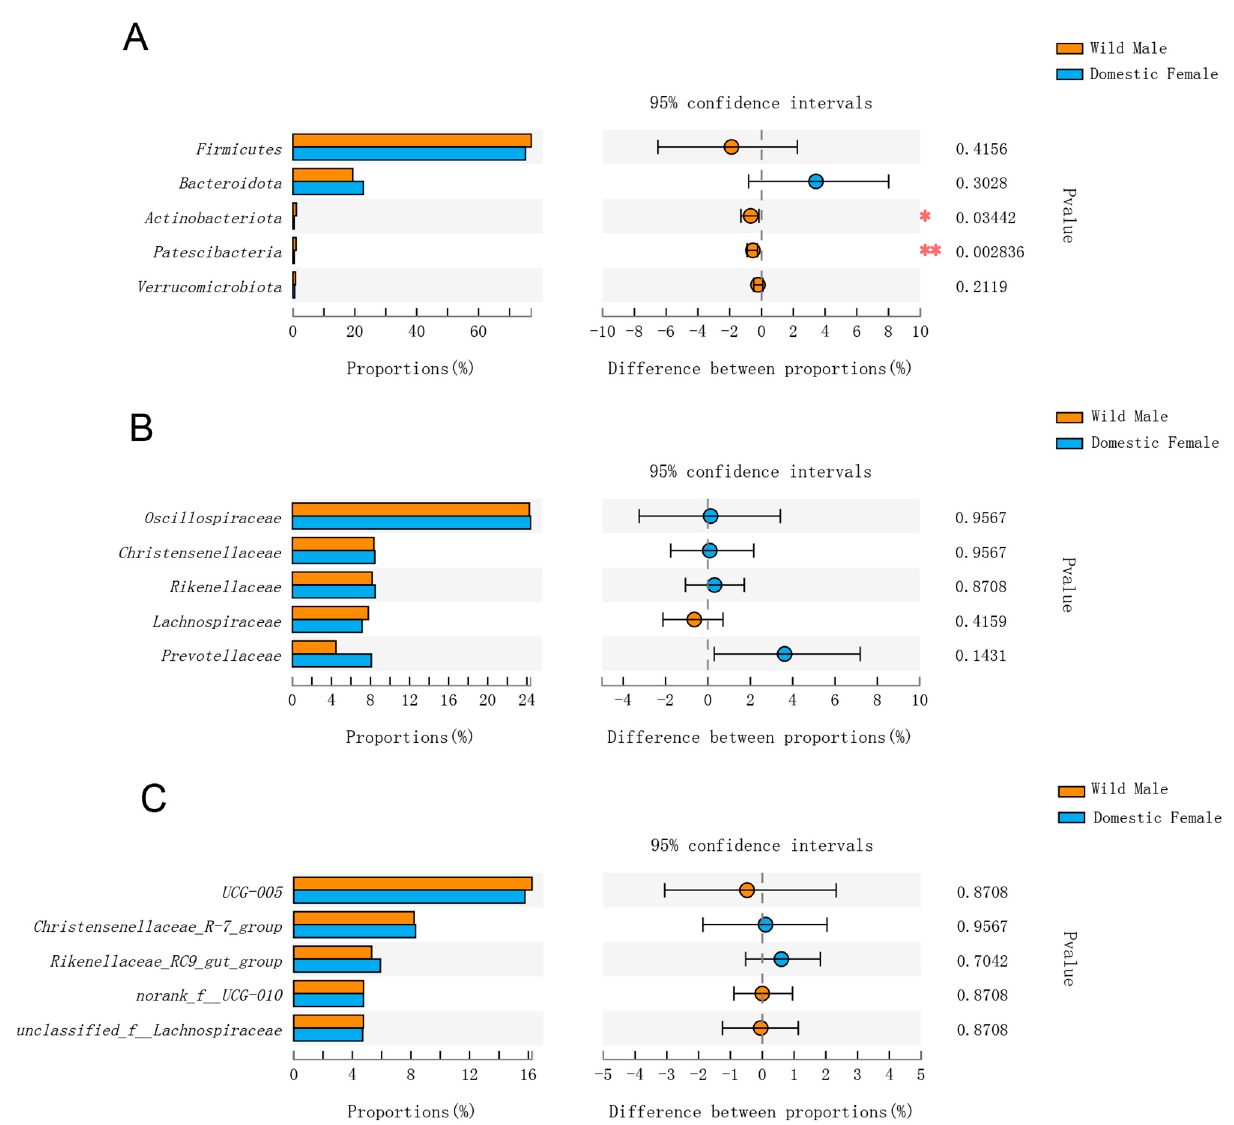
Figure 4. Comparison of gut microbial diversity between domestic Datong females and wild male yaks. ( A ) Top five phyla; ( B ) top five families; ( C ) top five genera. Significant differences in the gut microbiota between domestic Datong females and wild male yaks are indicated by p values and asterisks (* if 0.01 < p < 0.05, ** if 0.001 < p < 0.01).